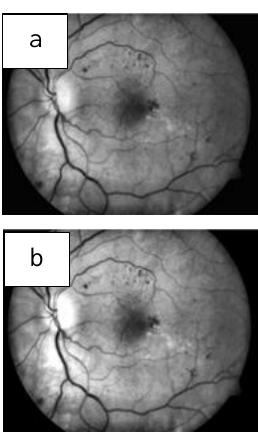
Fig. 4. The results of pre-processing: (a) CLAHE; (b) contrast adjustment